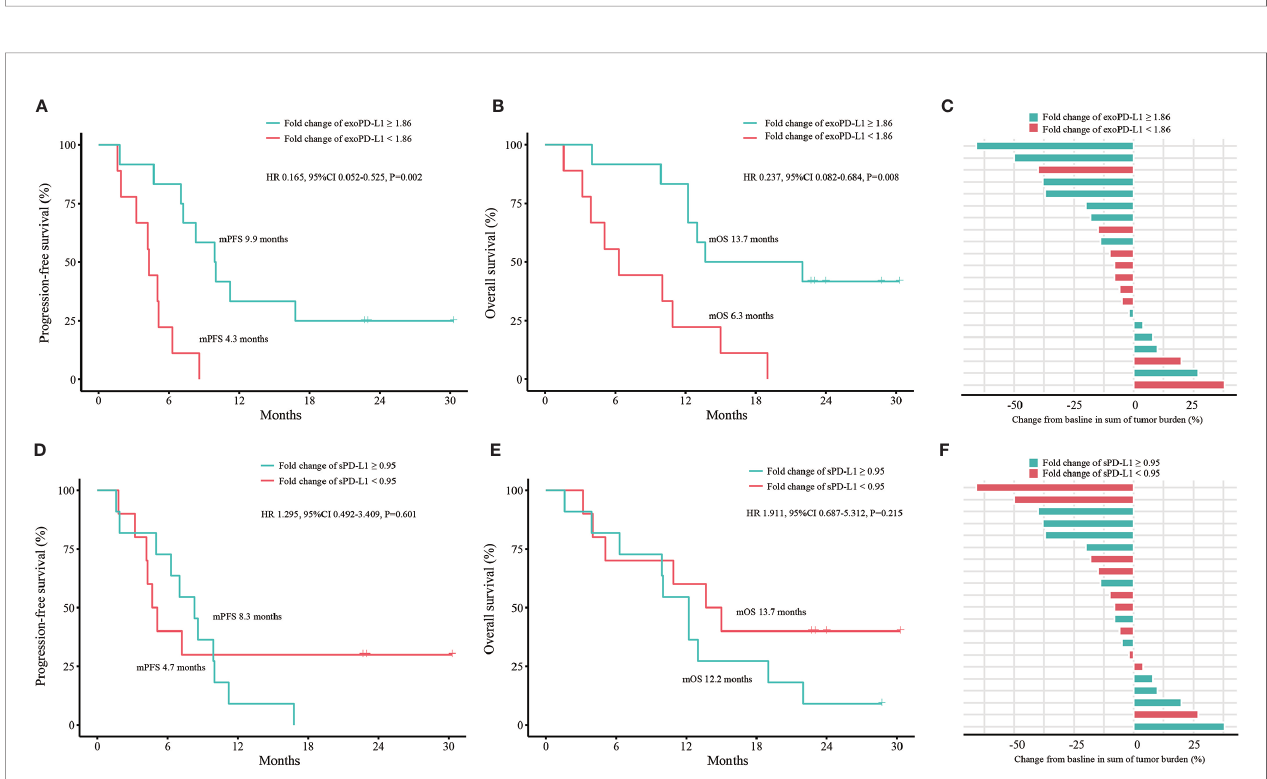
FIGURE 3 | Dynamic change in PD-L1 mRNA expression to predict ef fi cacy and OS in the expanded 40 NSCLC cohort. (A) PFS analysis based on fold change of PD-L1 mRNA expression. (B) OS analysis based on fold change of PD-L1 mRNA expression. (C) bOR of each patient strati fi ed by fold change of PD-L1 mRNA expression. OS, overall survival; PFS, progression-free survival; bOR, best objective response; HR, hazard ratio; CI, con fi dence interval. P values were calculated by log-rank